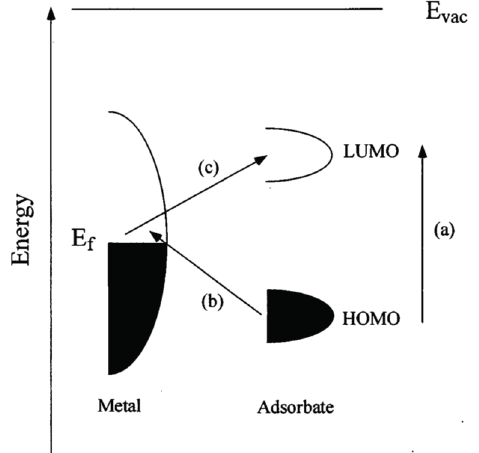
Figure 2. Typical diagram of energy band of a molecule adsorbed on a metal surface.